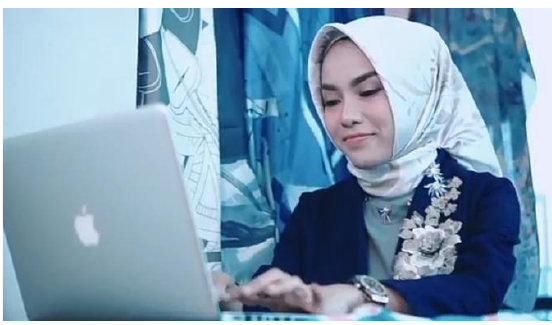
Figure 4: A Career Muslim